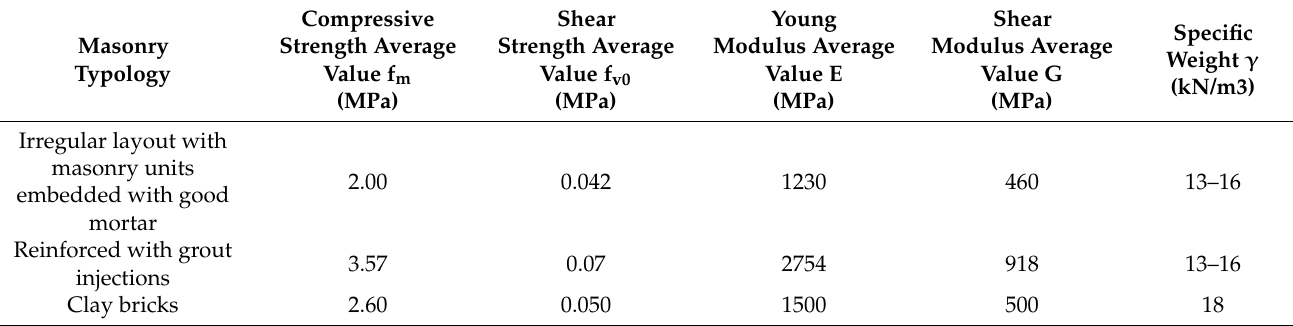
Table 1. Mechanical parameters of the masonry.